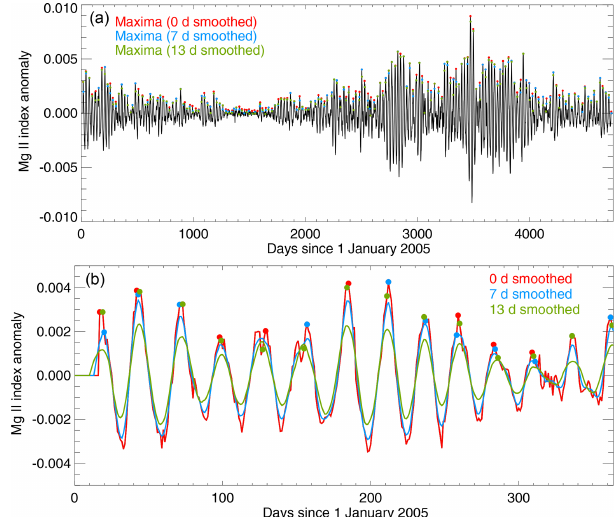
Figure 6. (a) Mg II index anomalies generated by subtracting a 35d running mean from the time series. The black line presents the un- smoothed or 0d smoothed Mg II index anomaly. The red, blue and green points are the local maxima chosen from the 0, 7 and 13d smoothed Mg II index anomalies, respectively. (b) Similar to (a) except for the year 2005 only. In addition, the red, blue and green lines present the Mg II index anomalies smoothed by a 0, 7 and 13d running mean,